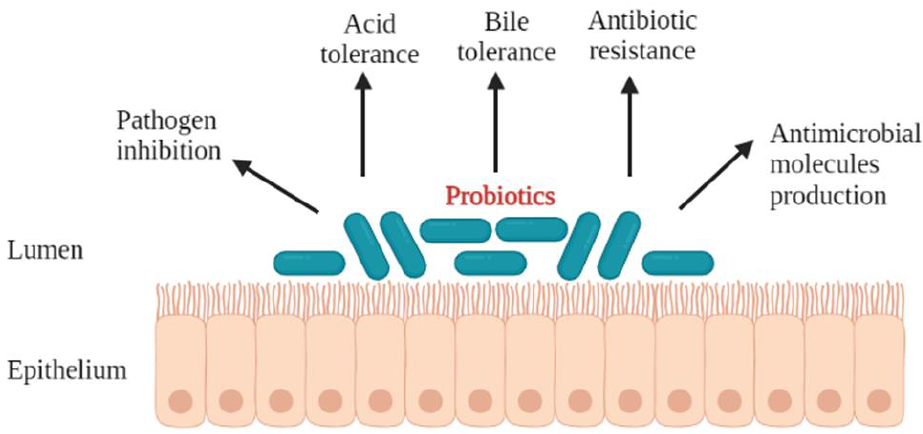
Figure 1. Desirable properties of the probiotic microorganisms.